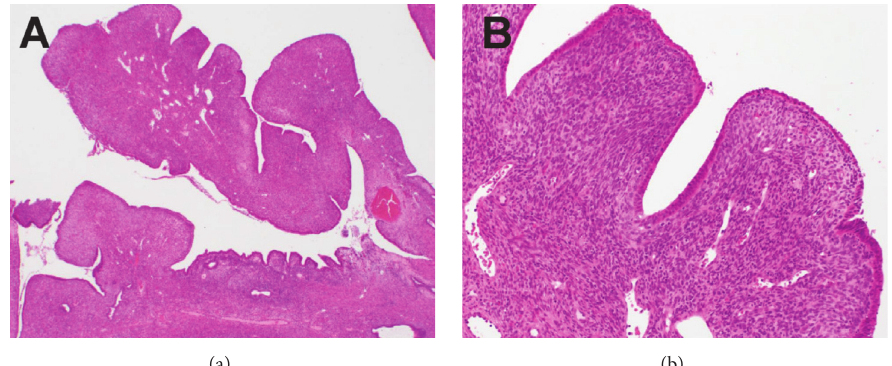
Figure 1: (a) Tumor cells with two components: endocervical glandular lesion without atypia of a phyllodes-like pattern and periglandular, spindle stromal cell condensation. (b) Stromal spindle cells with mild nuclear atypia. The mitotic counts were greater than two mitotic figures/10 HPF.